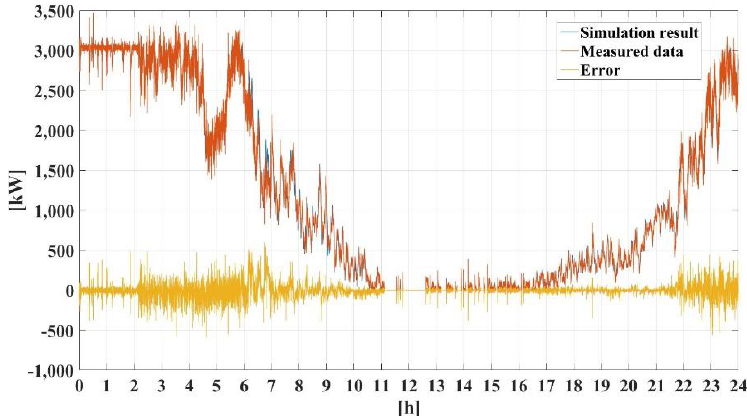
Energies 2020 , 13 , x FOR PEER REVIEW Figure 21. Field test and simulation results: total output powers and error. Figure 21. Field test and simulation results: total output powers and error. Figure 21. Field test and simulation results: total output powers and error.